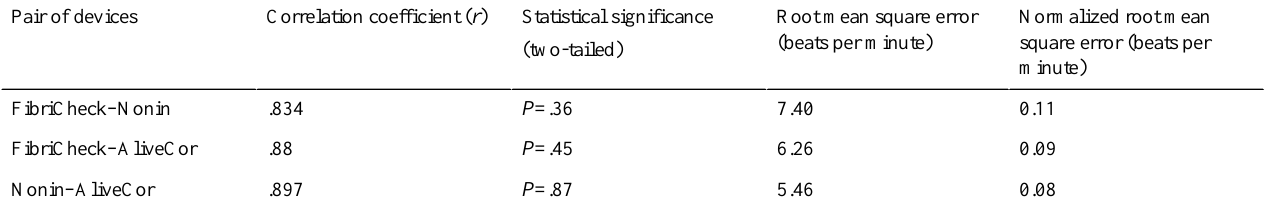
Table 3. Correlation coefficients, statistical significance, root mean square error, and normalized root mean square error for each pair of devices.